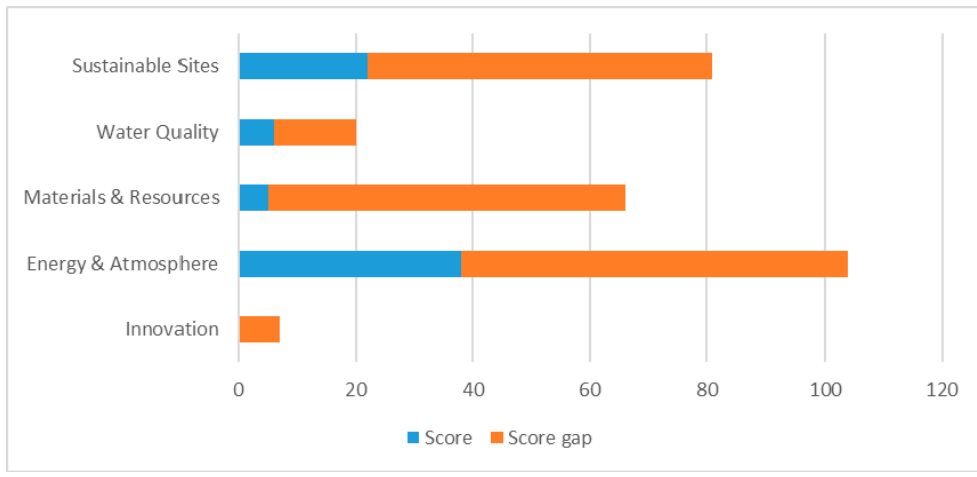
Figure 5. Points achieved in relation to applicable points across each category of the GreenLITES rating system for Project 1.